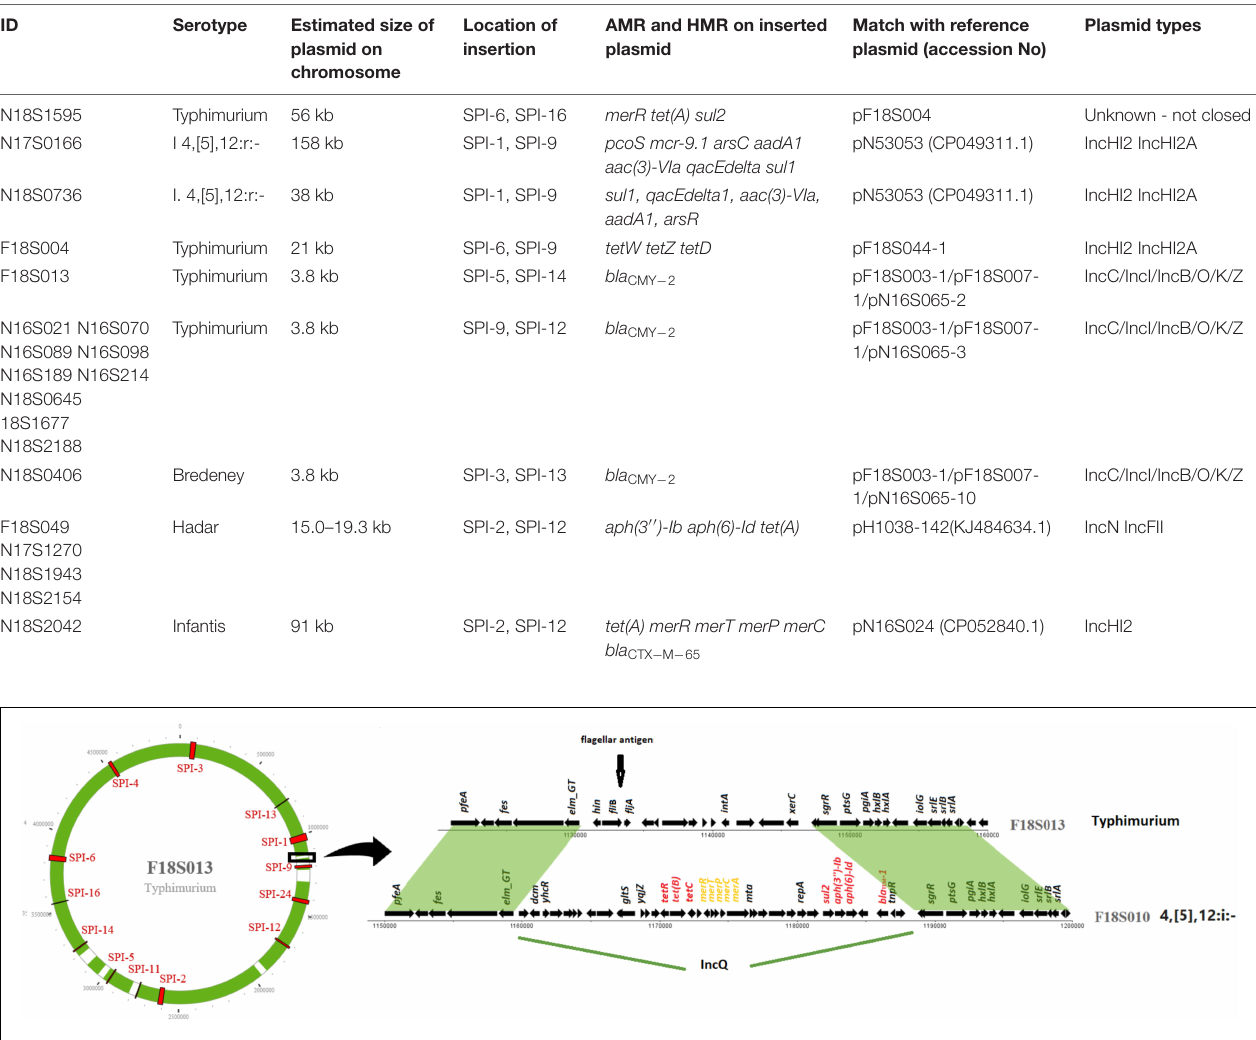
N18S0173, and N18S2170) carried multiple chromosomal ARGs ( Supplementary Table 1 ). These isolates encompassed seven different